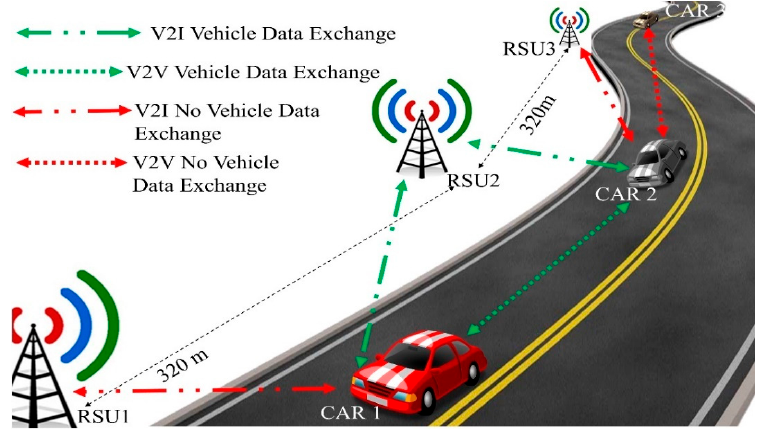
Figure 2. The proposed V2X communication architecture.